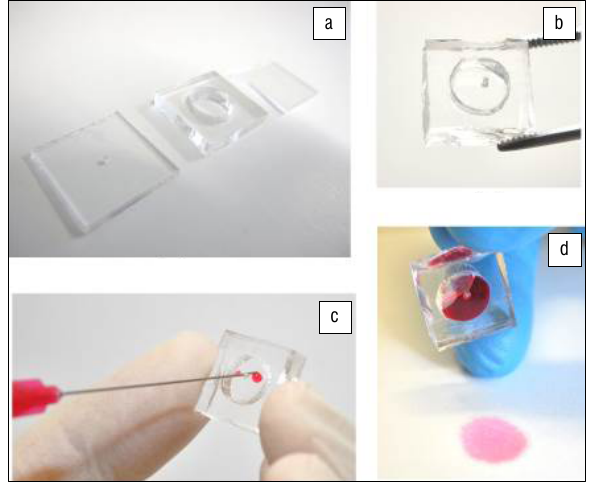
Figure 7: Sample delivery ‘button’ design and manufacture: (a) three polydimethylsiloxane (PDMS) blocks are layered with a 1 mm punched hole as outlet, a 10 mm punched hole as reservoir, and a blank cover; (b) assembling the layers with liquid PDMS produces a sealed ‘button’ device; (c) preloading the ‘button’ by injecting a reagent using a syringe and needle tip; (d) sample spot delivered onto paper by pressing on the ‘button’.